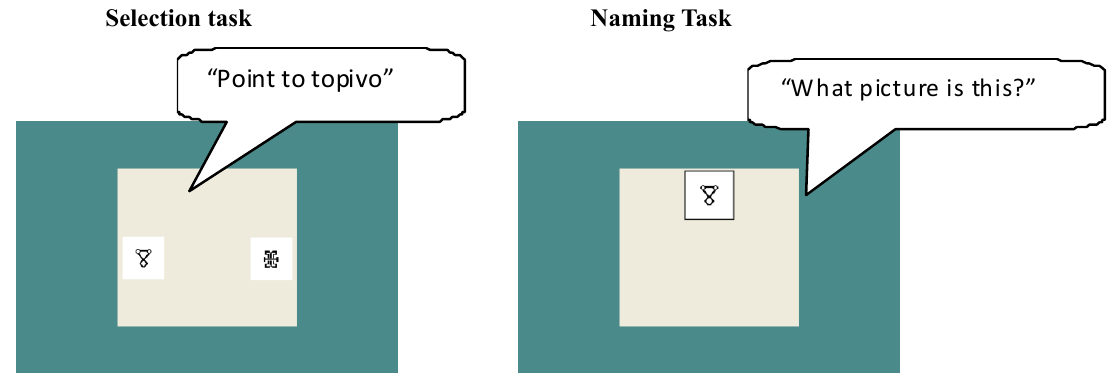
Figure 1 . Illustrative screen of one trial of the selection tasks (left panel) and one trial of the naming tasks (right panel).